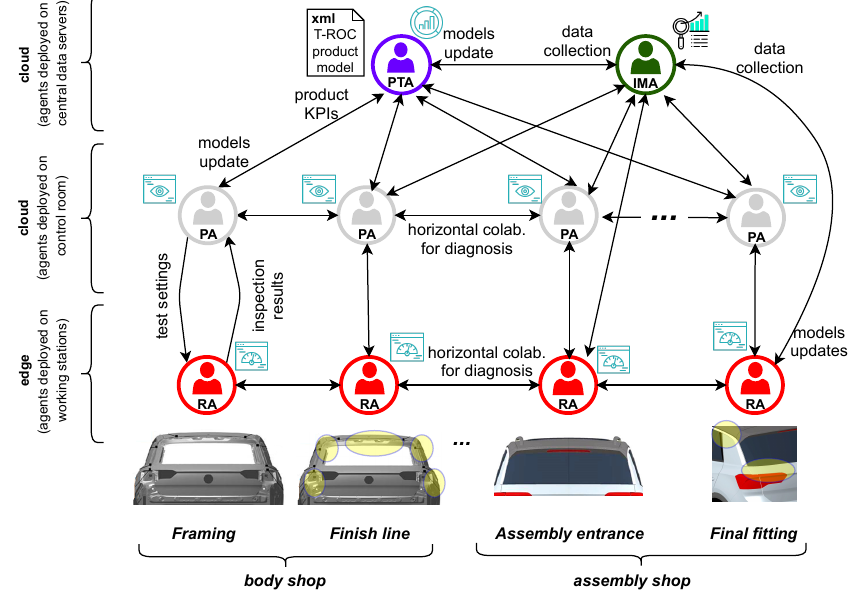
Figure 8. Application of an agent-based CPS to an automotive assembly